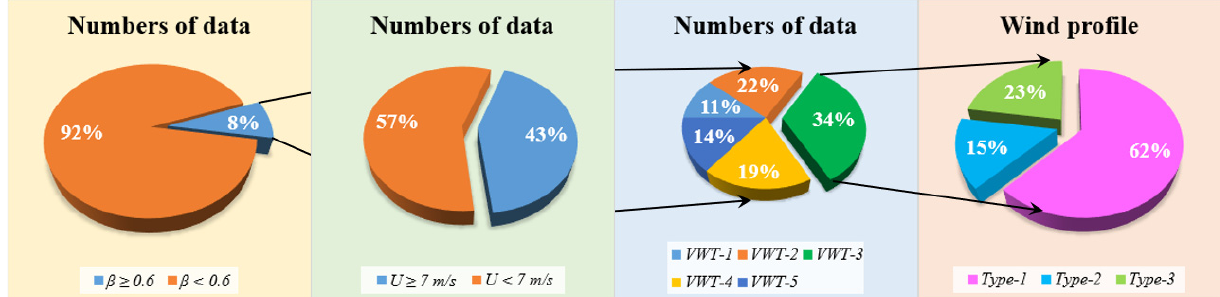
Figure 8. Time history of wind speed.